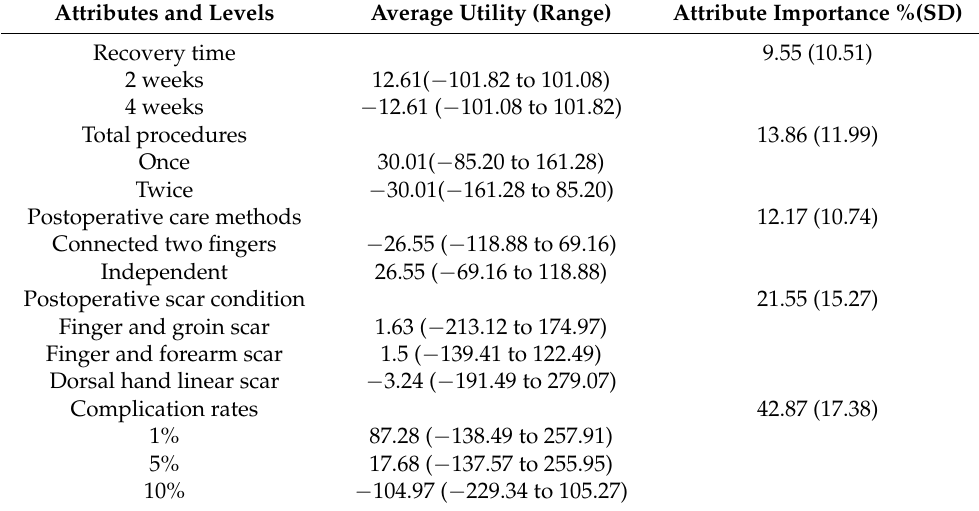
Table 3. Outcome of conjoint analysis of preference of reconstruction surgery in patients with hand trauma ( n =